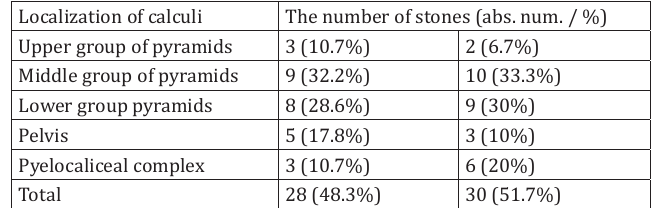
Indicator of localization of calculi in the kidneys, total - 58